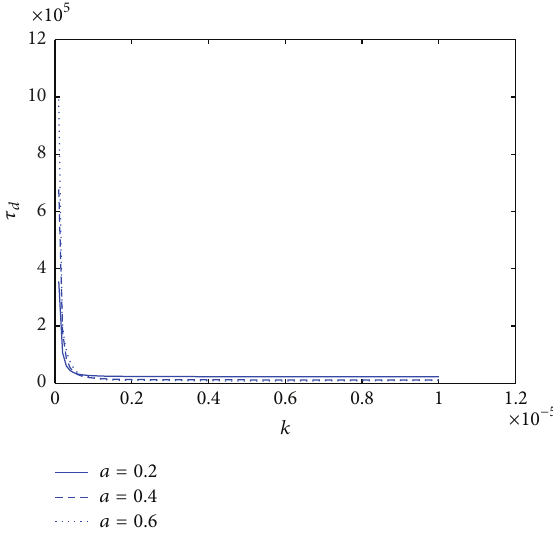
Figure 2: Damping time 𝜏 𝑑 of slow waves versus wavenumber k .